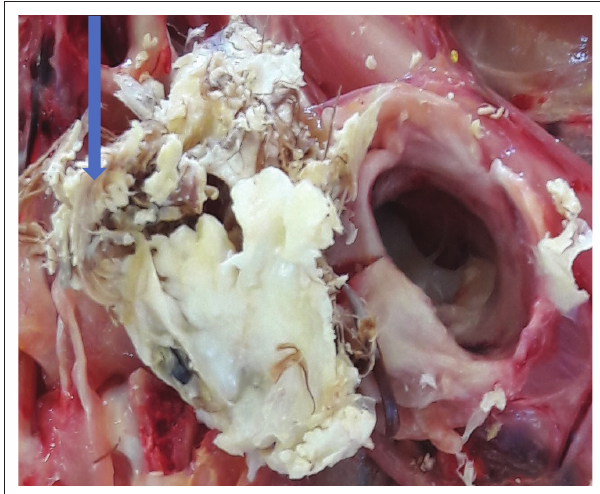
FIGURE 5: A close-up picture clearly depicting a feather within the cyst contents as shown by the